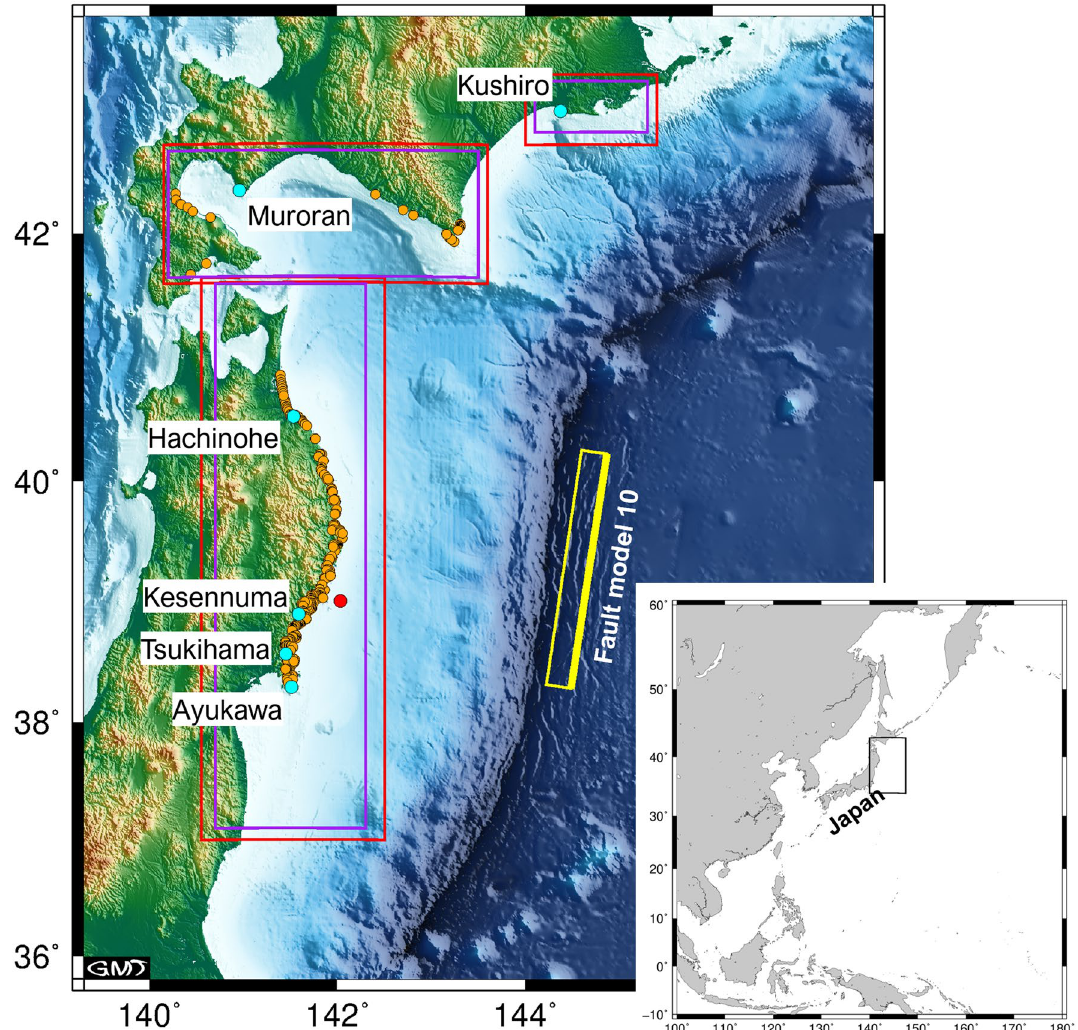
Figure 2. Map of the tsunami simulation region showing the distribution of the observed tsunami inundation data for the 1933 Showa-Sanriku tsunami (orange circles). The narrow yellow rectangle is a projection of the outer edge of fault model 10 (Table S1). The thick yellow line is the upper edge of the fault. Red and purple rectangles are the nested 6-arc-sec and 2-arc-sec gridded domains, respectively, used in the tsunami simulations. The root domain is gridded by 18-arc-sec intervals. The red circle indicates the location of the tsunami waveforms shown in Fig. 5. The cyan circles indicate the tide gauges used in Fig. 7. We used GMT 64 Version 5.4.5 to prepare the